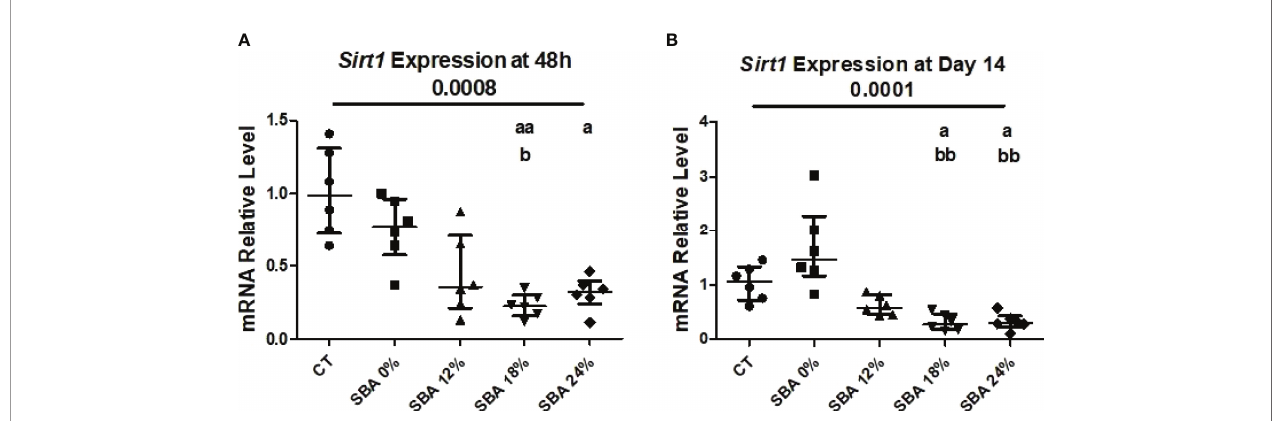
FIGURE 6 | 10-week SBA protocol induced a suppression of SIRT1 mRNA level. (A, B) Relative mRNA expression level of sirtuin type 1 ( Sirt1 ) in CT and SBA groups (0%, 12%, 18%, 24%), cells were cultured for 48 hours in standard growth media and for 14 days were exposed to co-differentiation media, respectively. Data represent median and interquartile range; n = 6. Statistical analysis was performed using Kruskal-Wallis One-Way ANOVA test and Dunn ’ s test; a - p < 0.05, aa - p < 0.005 when compared to the CT group (b – when compared to the SBA 0%